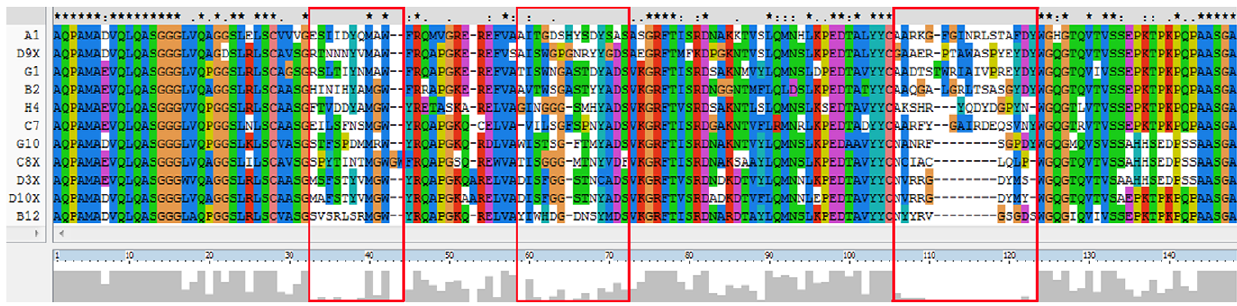
Figure 1. Amino acid alignments of sdAb families. Families were identified based on amino acid alignments and variability in the complementarity determining regions (CDRs) bracketed in red boxes. Single representatives of each family are shown here. Clones d3x, d9x, G1, H4, and C8x are members of families that are not described in this study.